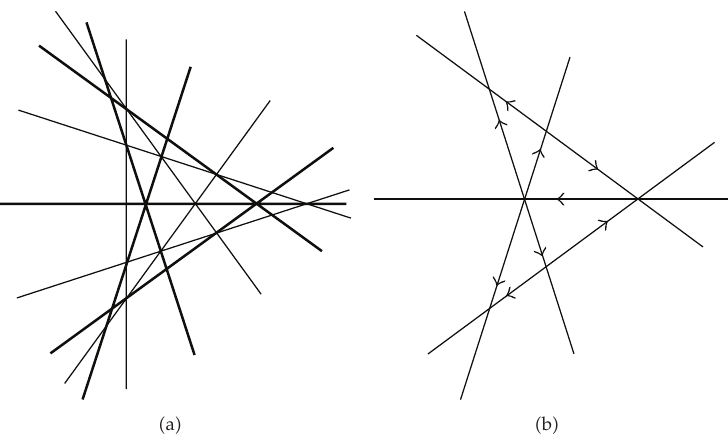
Figure 1: System of lines for d (cid:5) 5 , 10 (cid:6) a (cid:7) and induced arrows for d (cid:5) 5 (cid:6) b (cid:7)